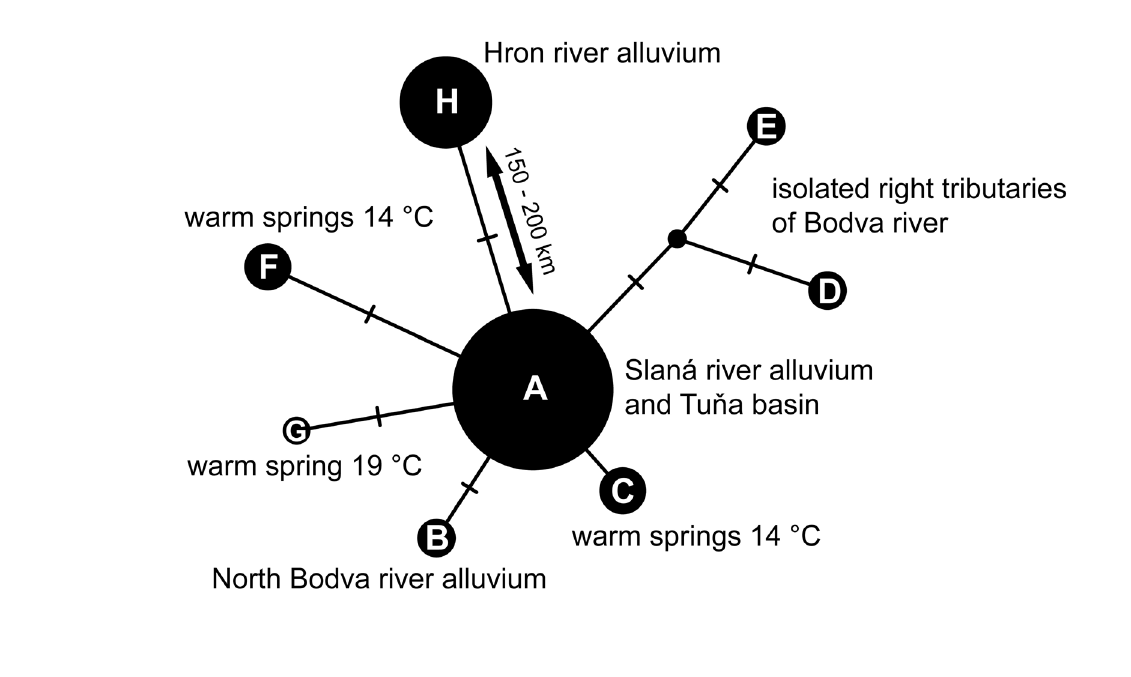
Fig. 10. Statistical parsimony network of H. kissdalmae Erőss & Petró, 2008 based on 16S rRNA. Haplotype circles A–H are proportional in size to the number of individuals with identical sequences. For comprehensive specimen information see Supp. file 1, Fig. S1. Crosslines and small circle represent non-sampled